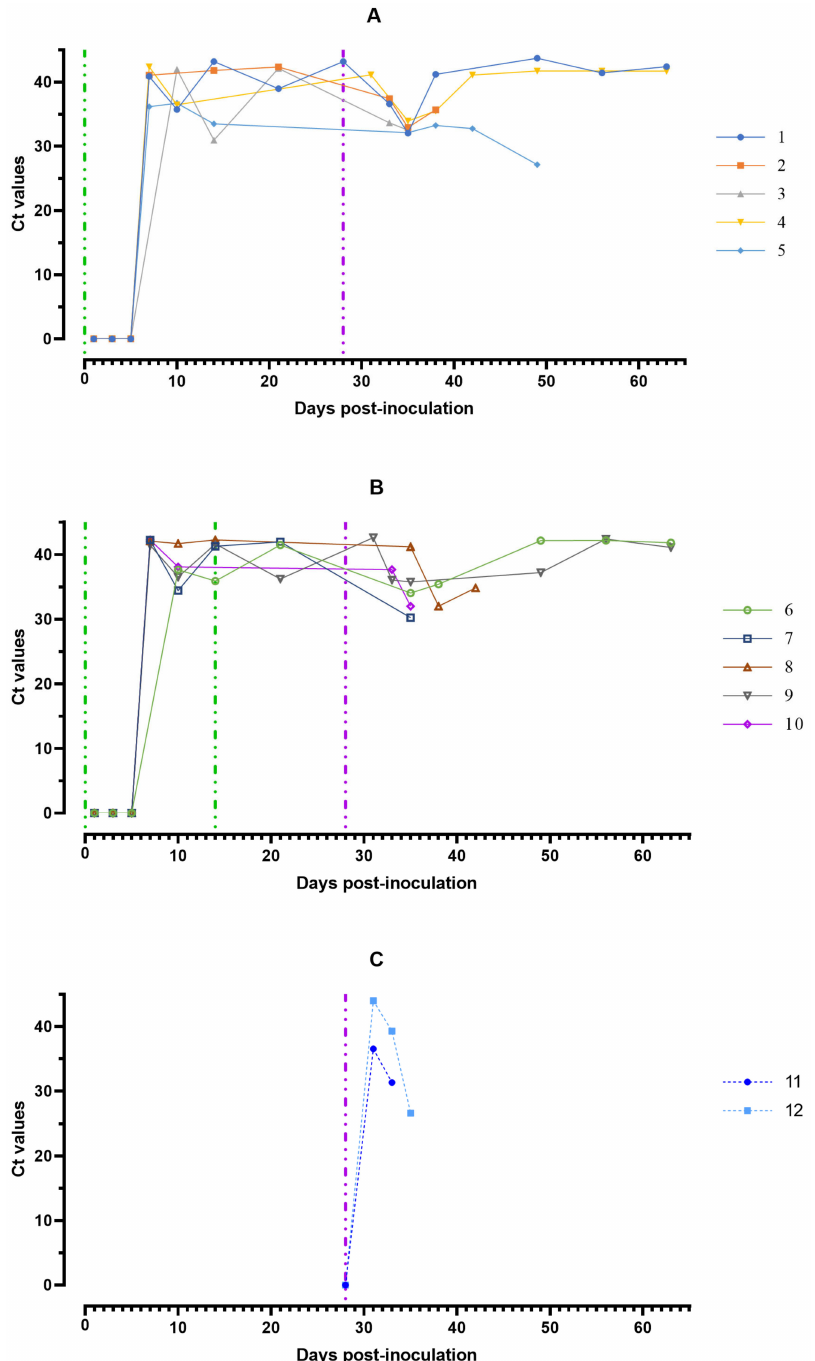
Figure 5. Values of ASFV-specific qPCR results of saliva samples of pigs from 0 to 63 dpi: ( A ) group #1 after inoculation with the ASFV-Katanga-350 and challenge on the 28th day with the ASFV-Stavropol 01/08; ( B ) group #2 after twice inoculation with the ASFV-Katanga-350 and challenge on the 28th day with the ASFV-Stavropol 01/08; ( C ) group #3 after challenge with the ASFV-Stavropol 01/08. Each curve represents the values of individual animals. Vertical dashed lines: green—days of inoculation of ASFV-Katanga-350, purple—challenge by the ASFV–Stavropol 01/08. From 7 dpi, the levels of virus-specific antibodies in blood serum samples were positive in 4 out of 10 pigs from groups #1 and 2. At 10 dpi, they reached maximum values and persisted until death or euthanasia of the animals (Figure 6). Infection at 28 dpi